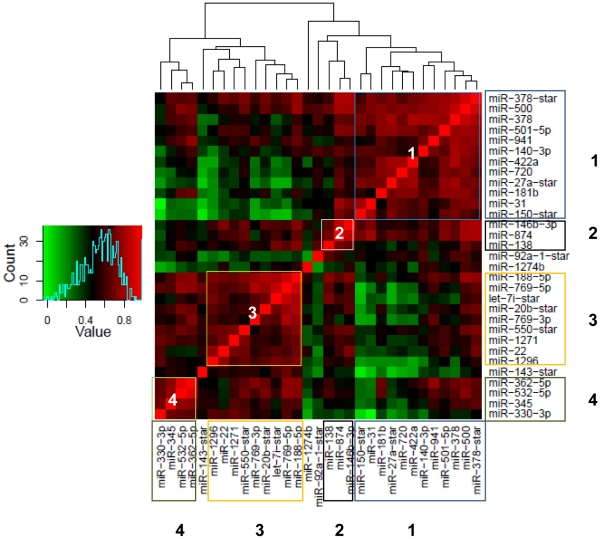
Sub-clusters of platelet-derived miRNA biomarkers.Unsupervised hierarchical clustering of miRNA biomarkers based on the Pearson correlation coefficients among the miRNA expression profiles from 20 patients and 20 controls. The coefficient values are shown in the bar scale. Each of the 4 main clusters with significant correlation values are indicated in boxes.